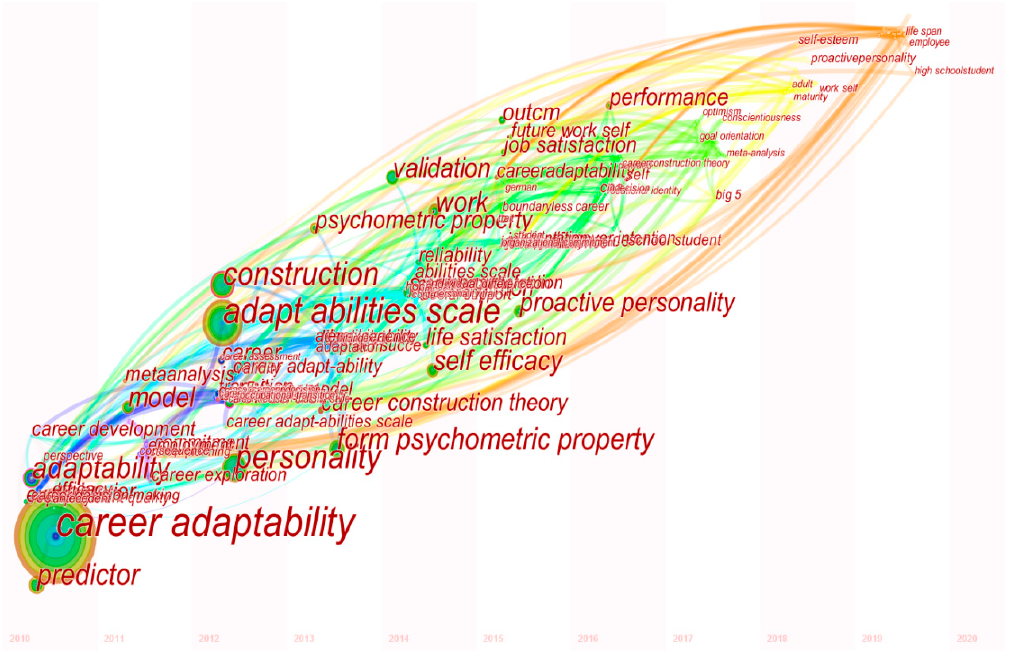
Figure 5. Network map of hotspots in career adaptability research.